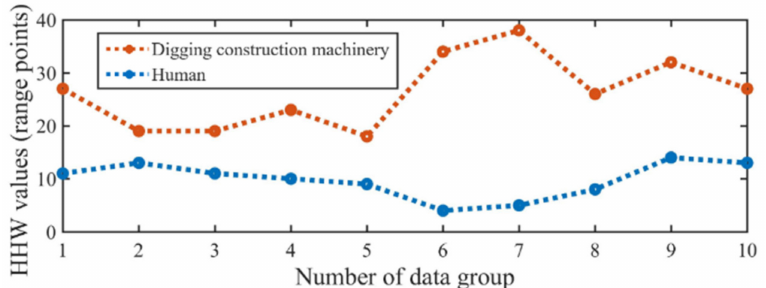
Figure 9. Comparison of HHW values of the 10 groups of radar data for human and digging construction machinery positions.